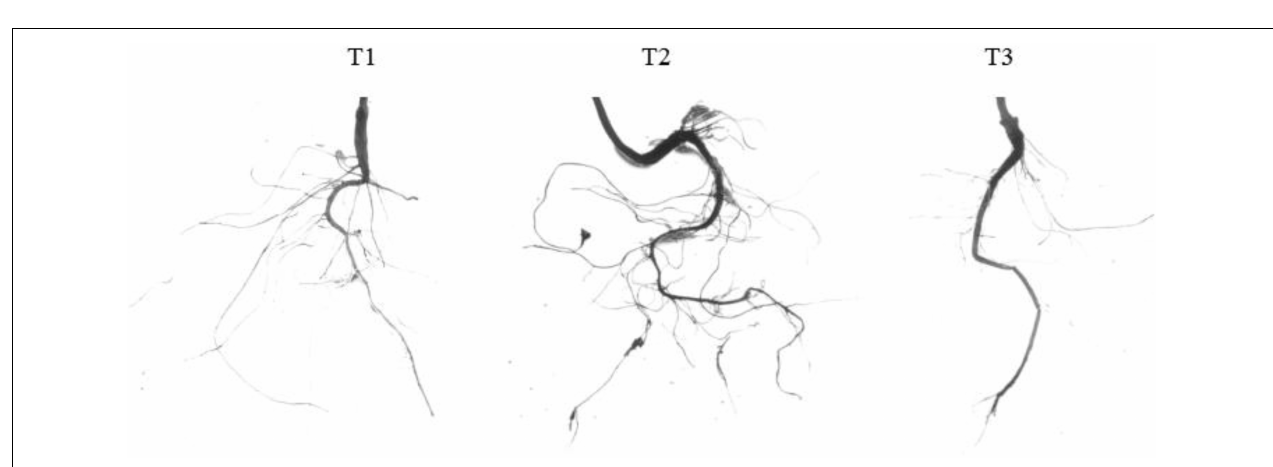
FIGURE 1 | Effects of different concentrations of sucrose on soluble sugar content (A) and SnRK1 activity (B) in peach roots. Error bars represent the averages of three biological replicates ± SD. Different letters represent differences between different processes. Significance was defined at P < 0.05. S1, water; S2, 1% sucrose solution; S3, 3% sucrose solution; S4, 5% sucrose solution; S5, 7% sucrose solution.